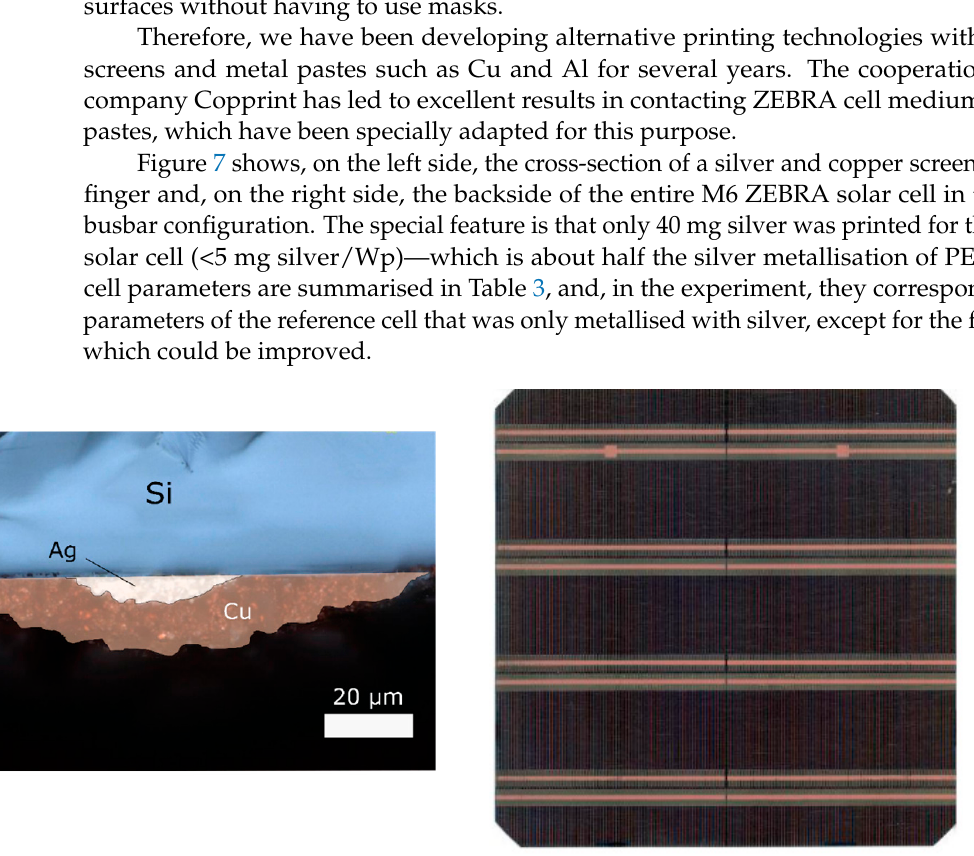
Figure 7. Cross sections of Ag/Cu-metallised finger contact ( left ) and Cu-metallised M6 4BB ZEBRA solar cell ( right ). Table 3. IV data of fully Ag-printed (reference) and Cu-printed ZEBRA solar cells with the same geometry (G1 wafer, 4BB) [14].